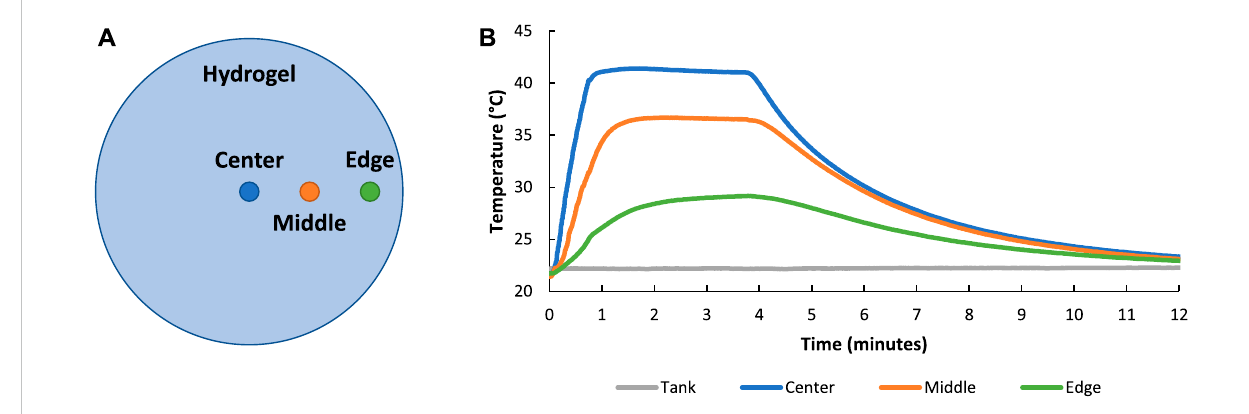
FIGURE 6 Image showing the location of thermocouples placed in the hydrogel to study thermal conduction of FUS treatment throughout the hydrogel volume (A) . FUS heating of composite hydrogel showed that heating was greater in the center of the hydrogel (nearest to the focal region of the transducer) when compared to the middle and edge of the hydrogel (further from the focal region of the transducer) (B) .